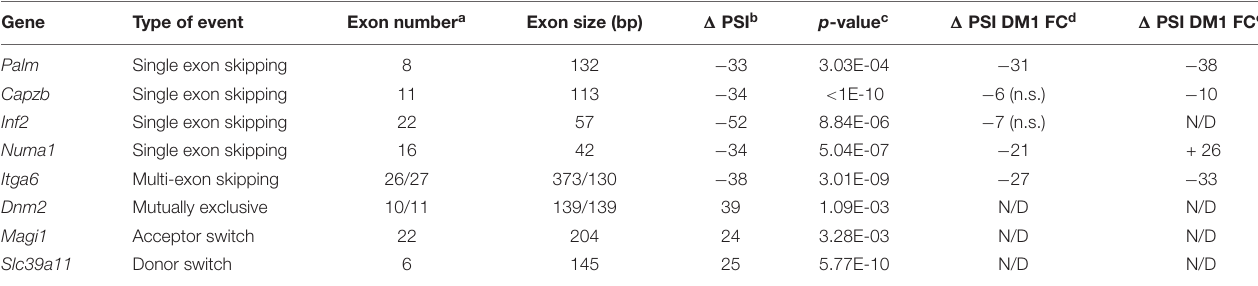
FIGURE 5 | Overview of splicing changes detected in DMSXL brain cells. (A) Distribution of all types of alternative splicing abnormalities studied among the different brain cell types. Percentage of events in each category. Absolute numbers are shown. (B) Number of cassette exons showing increased inclusion (positive (cid:49) PSI) or exclusion/skipping (negative (cid:49) PSI) in primary DMSXL cells, compared to WT controls. (C) Expression rations for human DMPK vs. total mouse Mbnl1 and Mbnl2 transcripts across brain cell types. (D) Venn Diagram showing overlapping splicing events dysregulated in DMSXL astrocytes and or DMSXL OL (representation factor: 24.0; p = 1.48E-11). TABLE 1 | Examples of splicing changes found in DMSXL astrocytes for each of the five categories of events